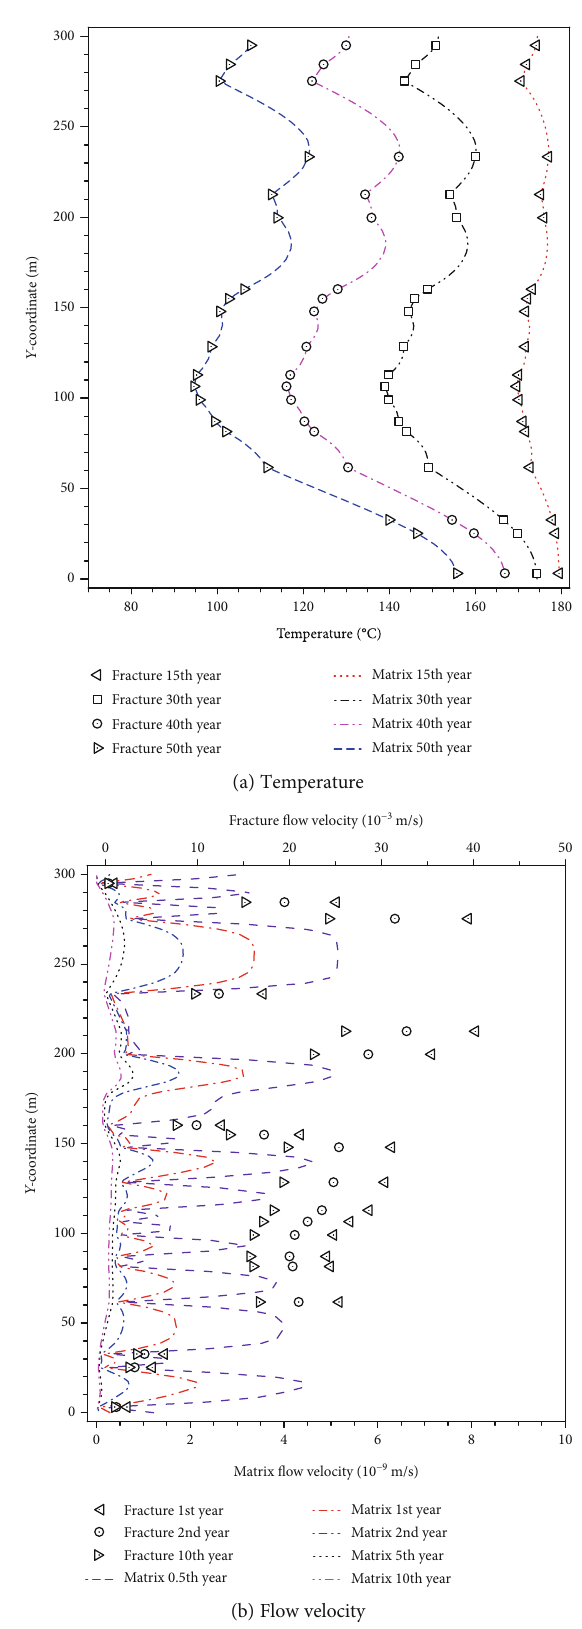
Figure 9: Outlet temperature and fl ow velocity at the di ff erent